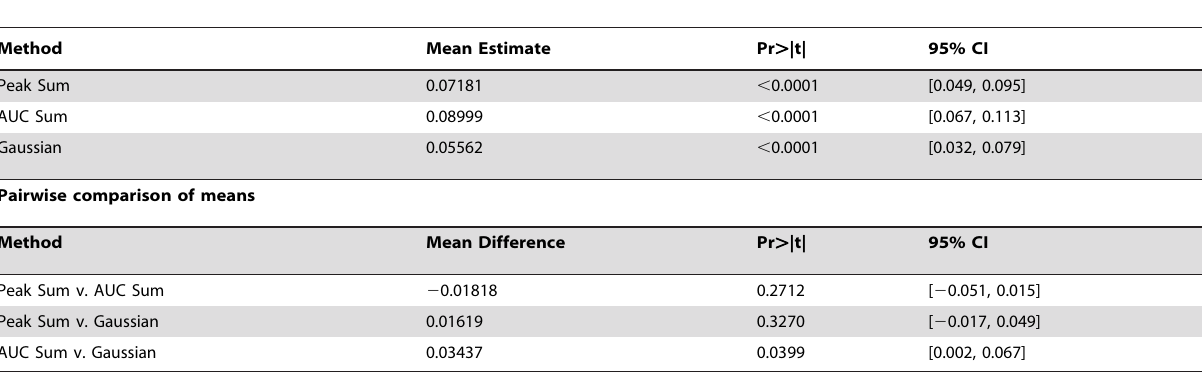
Table 2. Two way ANOVA with pairwise